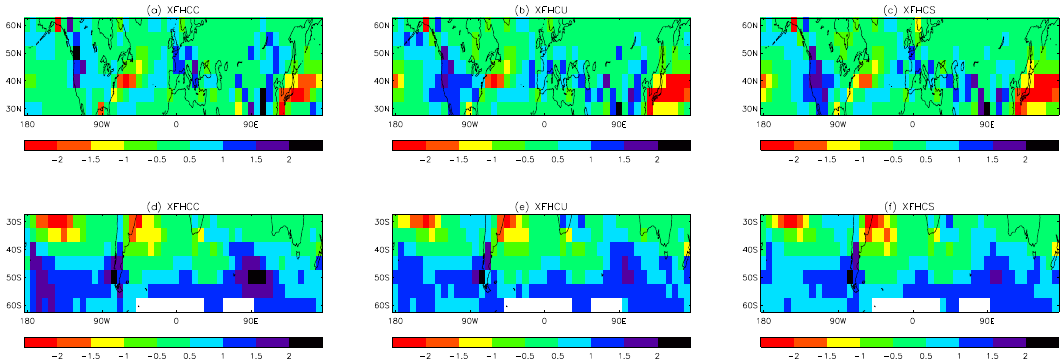
Fig. 13. Difference between simulated and observed precipitation in the northern (a–c) and southern (d–f) mid-latitudes as shown globally in Fig. 12. Note the different contour intervals compared to Fig. 12.